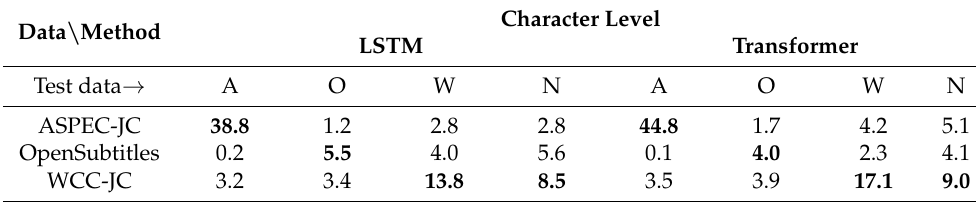
Table 6. Chinese → Japanese translation experiment results in character level (BLEU values).